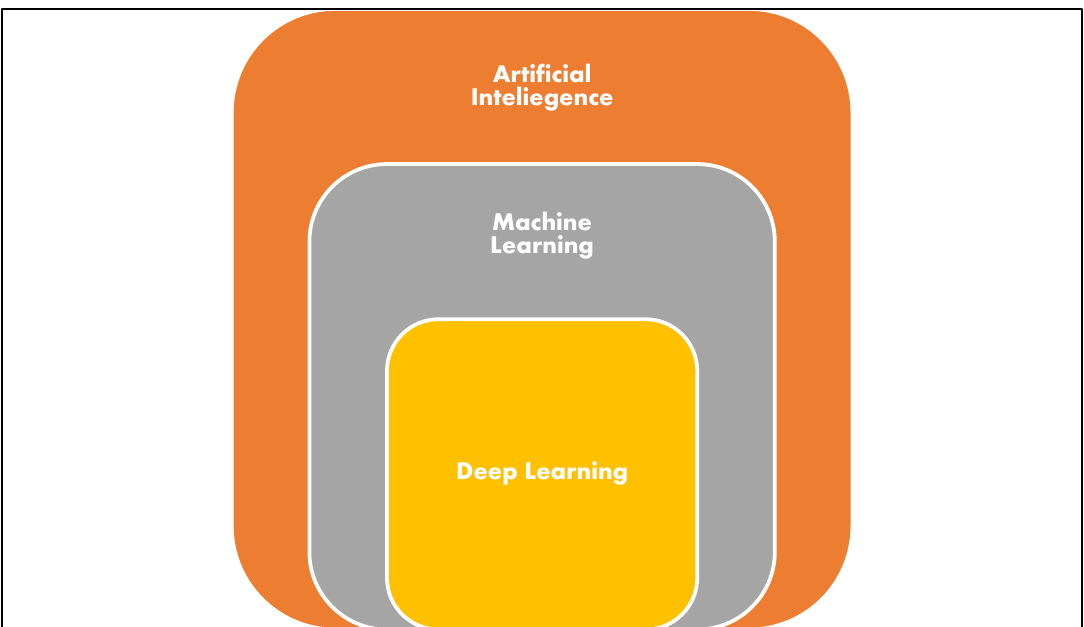
Figure 2. Machine Learning, Deep Learning and Artificial Intelligence developed from [11].